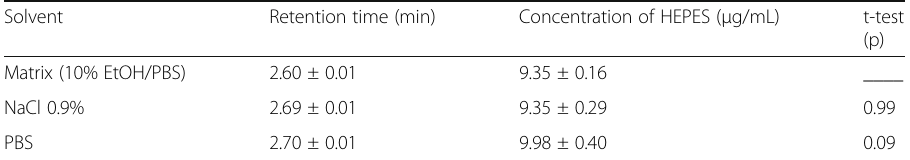
mL (Fig. 5a). The Pearson ’ s correlation coefficient of r = 0.9988 (Fig. 5b) confirmed the significant relationship between both calibration curves.